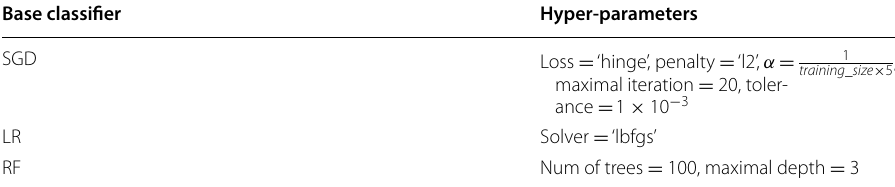
Table 7 The setup of the baseline machine learning models